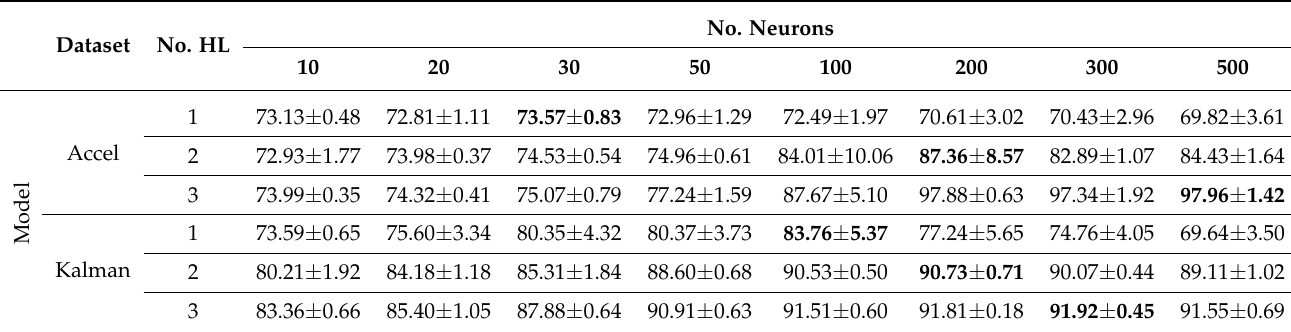
Table A1. Average of the results obtained over the different cross-validation folds for each of the studied configurations. The best results for each dataset and number of layers are highlighted in bold. Dataset